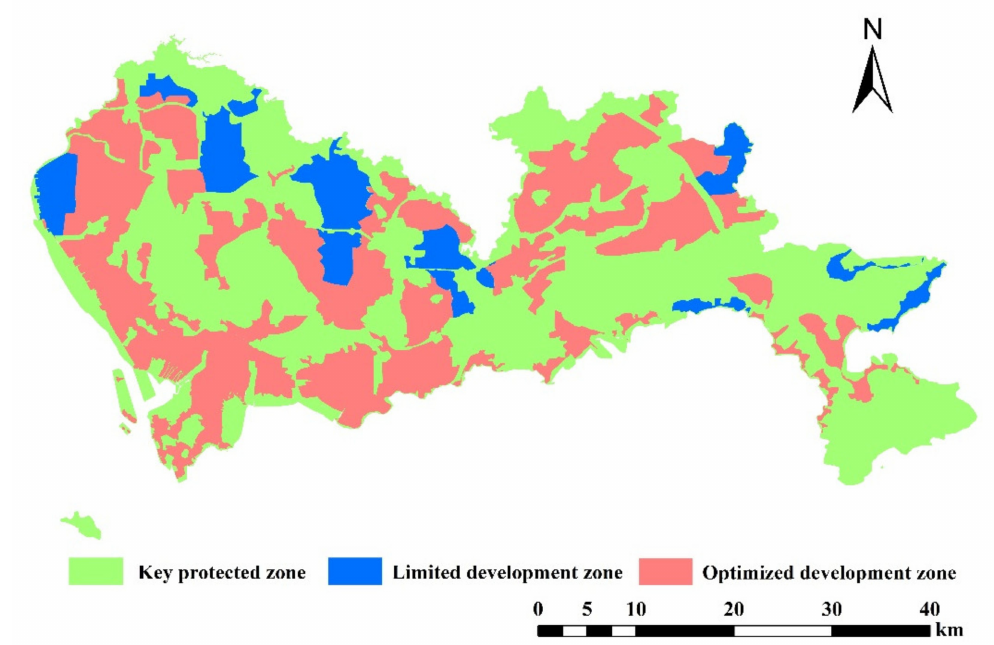
Figure 11. Ecological function zoning in the “Ecological City Construction Plan of Shenzhen” (revised from the General Office of the People’s Government of Shenzhen Municipality